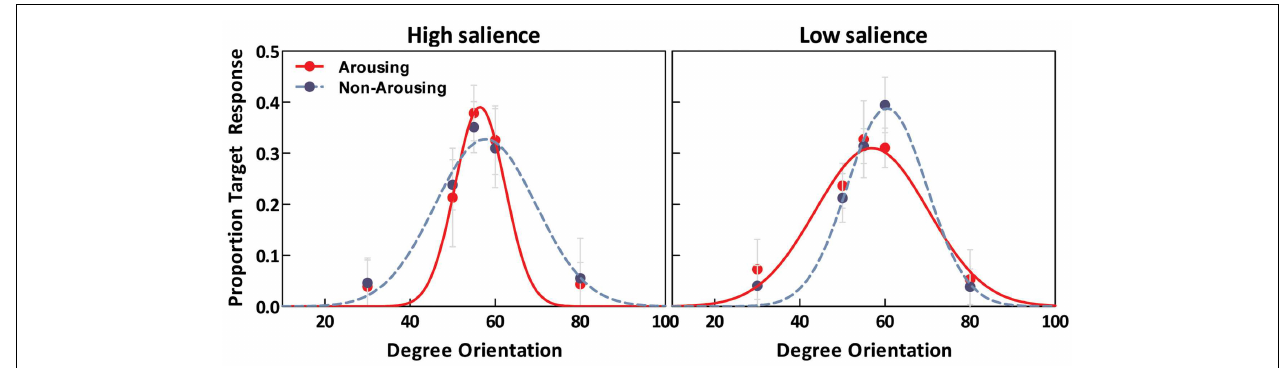
FIGURE 4 | Estimated tuning curves for averaged “target” responses as a function of emotion in the high-salience condition (left) and low-salience condition (right).